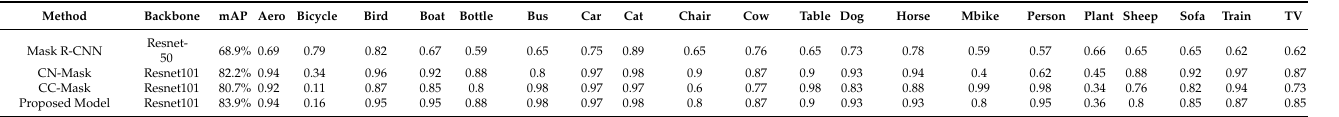
Table 2. Ablation experiments for the proposed model.